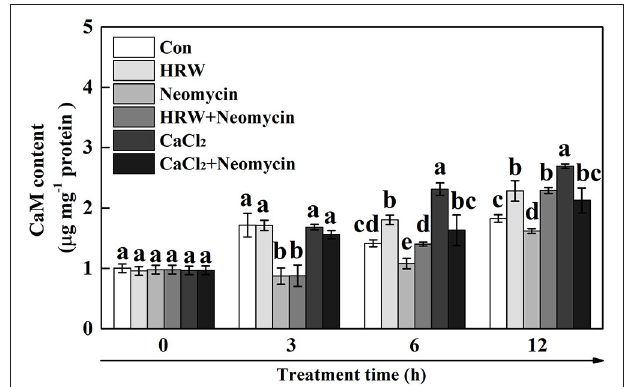
FIGURE 6 | Effects of HRW, CaCl 2 , and Ca 2 + antagonists on CaM content of radish sprouts hypocotyls under UV-A irradiation. After cultured in distilled water in the dark for 36h, radish sprouts were incubated in HRW (100% saturation), 10mM CaCl 2 , 1mM EGTA or 1mM Neomycin alone, or the combinations. The sample with distilled water alone was the control (Con). The CaM content was measured at 0, 3, 6 and 12h plant growth under UV-A, respectively. Data are presented as means ± SE ( n = 3). Bars with different letters are significantly different at P < 0.05 according to Duncan’s multiple test.